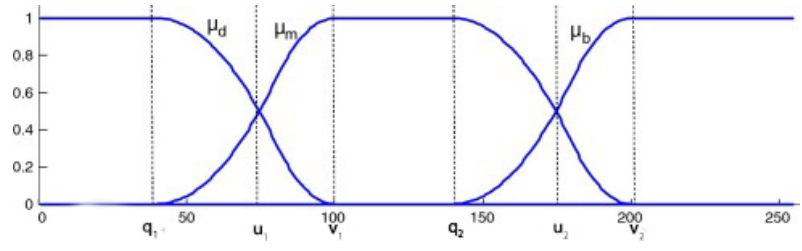
Figure 1. Membership function